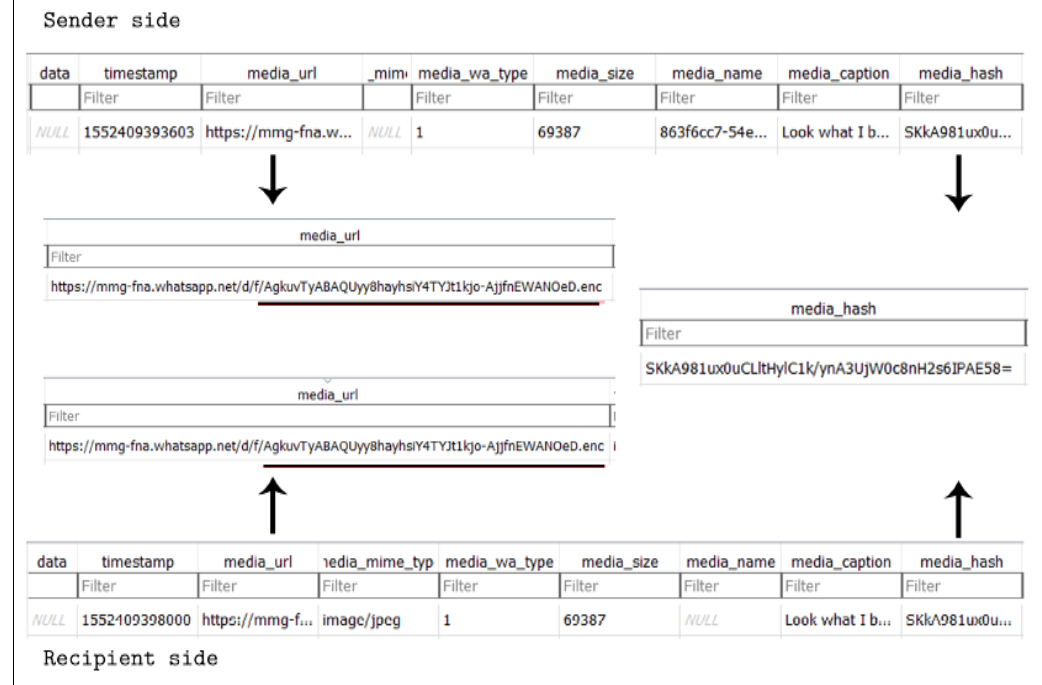
Figure 14. Multimedia message content: the sender and the recipient